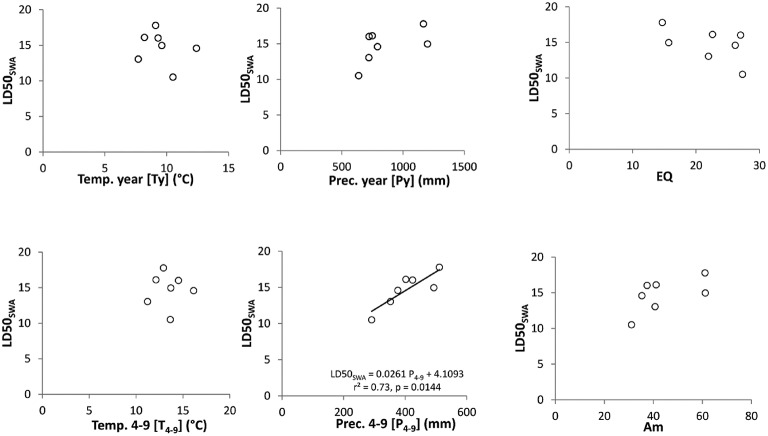
Relationships between climate parameters and LD50SWA. Left: temperature with mean annual temperature (Ty, above) and mean temperature during growing season (T4−9, below); middle: precipitation with mean annual precipitation (Py, above) and mean precipitation during growing season (P4−9, below); right: climate indices with Ellenberg Climate Quotient (EQ, above) and Aridity index of De Martonne (Am, below). The linear regression line displays a significant predictor effect of precipitation during the growing season (P4−9) on LDSOswA (seep values).